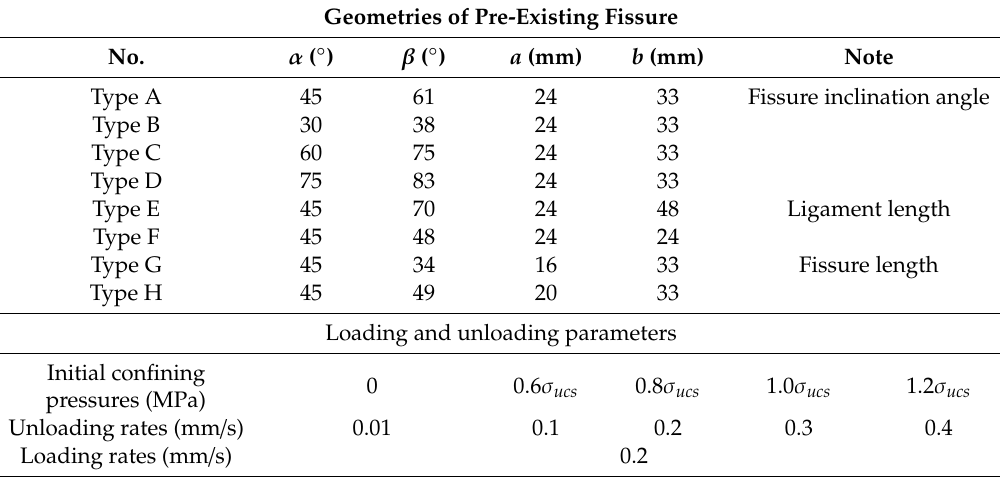
Figure 6. Geometric conditions of pre-fissured marbles. Table 2. Geometric and loading parameters of pre-fissured marble specimens.